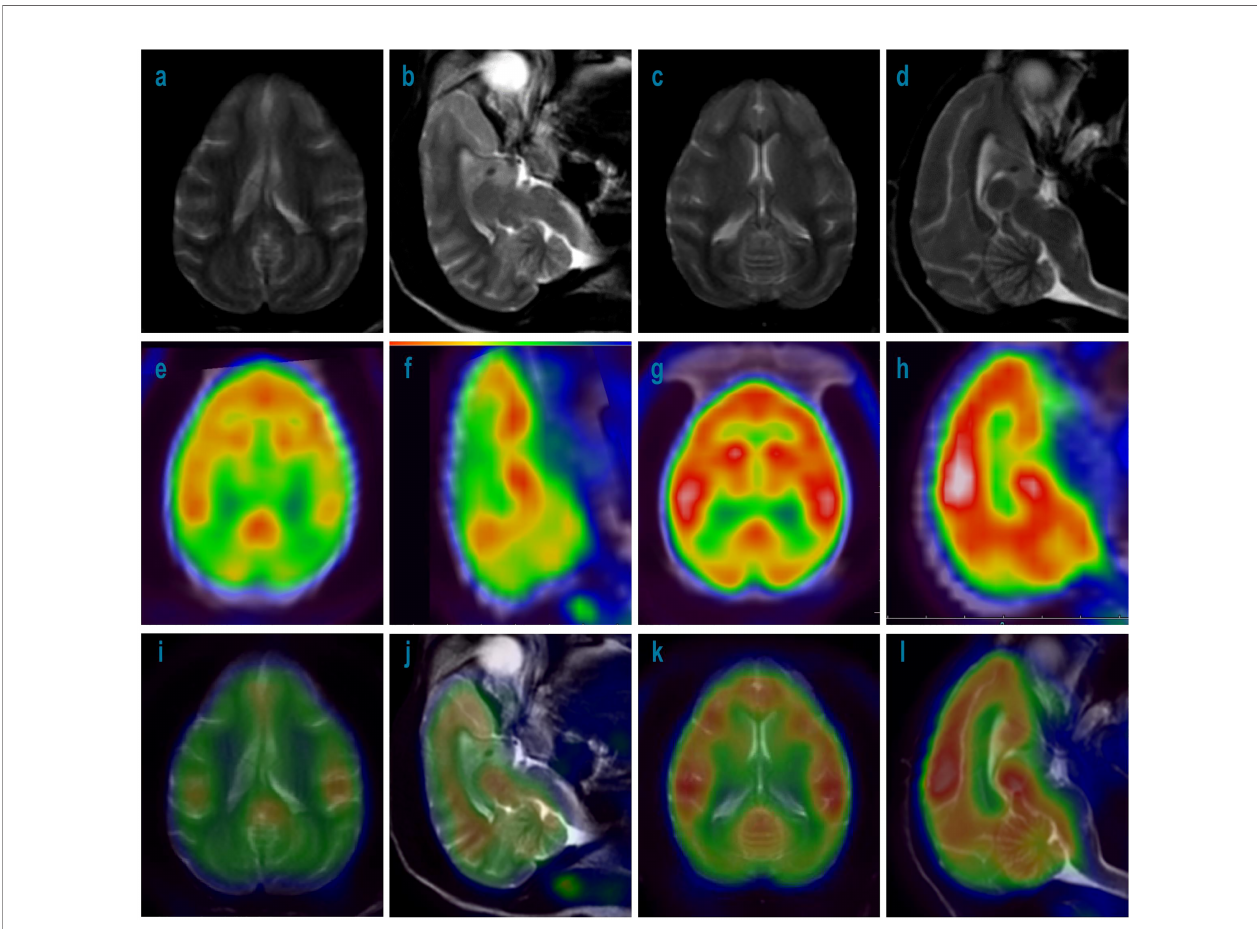
FIGURE 7 | MRI and 18F-FDG-PET imaging of cynomolgus monkey brains with 52-week administration of Jintrolong and control after 148- week recovery. (A) MRI imaging for axial source of excipient control group. (B) MRI imaging for sagittal source of excipient control group. (C) MRI imaging for axial source of 3 mg/kg/week Jintrolong group. (D) MRI imaging for sagittal source of 3 mg/kg/week Jintrolong group. (E – H) corresponding 18F-FDG-PET imaging. (I – L) corresponding imaging merged by MRI and